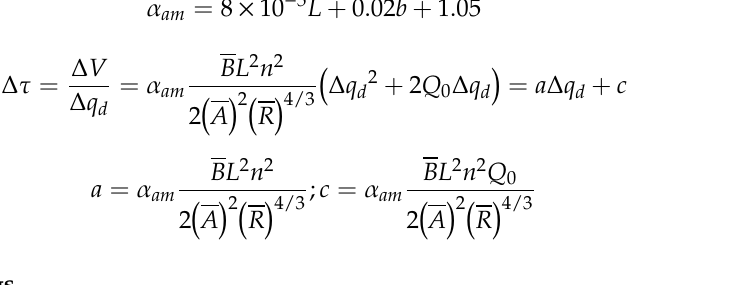
Table 1. Parameters identified by water balance model algorithm.